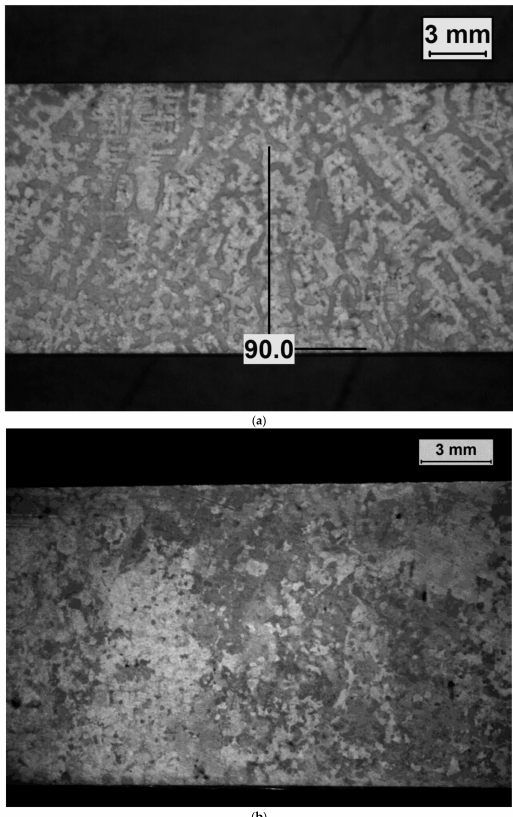
Figure 8. ( a ) Angle between the dendrite arms and the axial plane at position T/2 on the pressure electro-slag remelted 800 mm in diameter ingot (PESR-800). ( b ) The angle between the dendrite arms and the axial plane was not determined at position T/2 on the pressure electro-slag remelted (PESR) 1050 mm in diameter